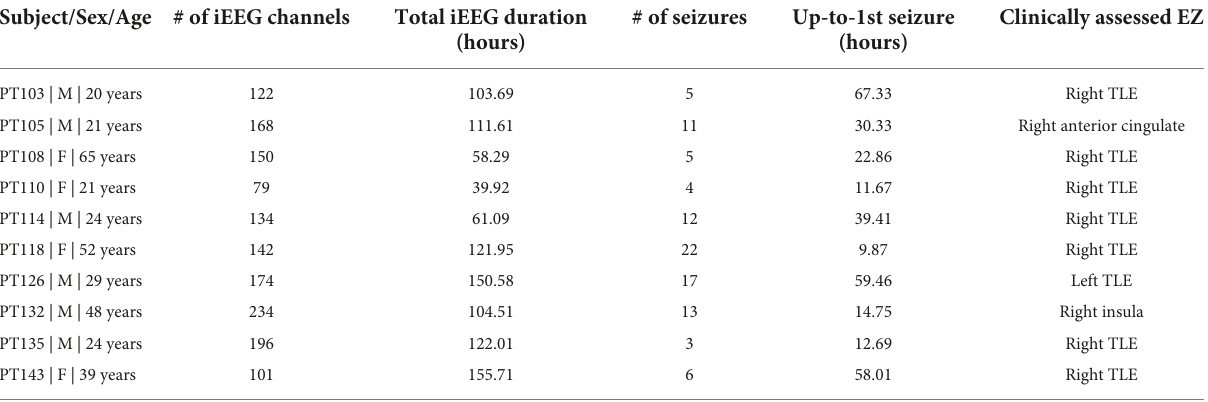
TABLE 1 Patient clinical and intracranial EEG (iEEG) information. Subject/Sex/Age # of iEEG